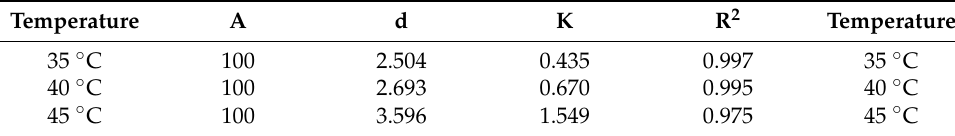
Table 4. Weibull model parameters at each process temperature (as reported in Equation